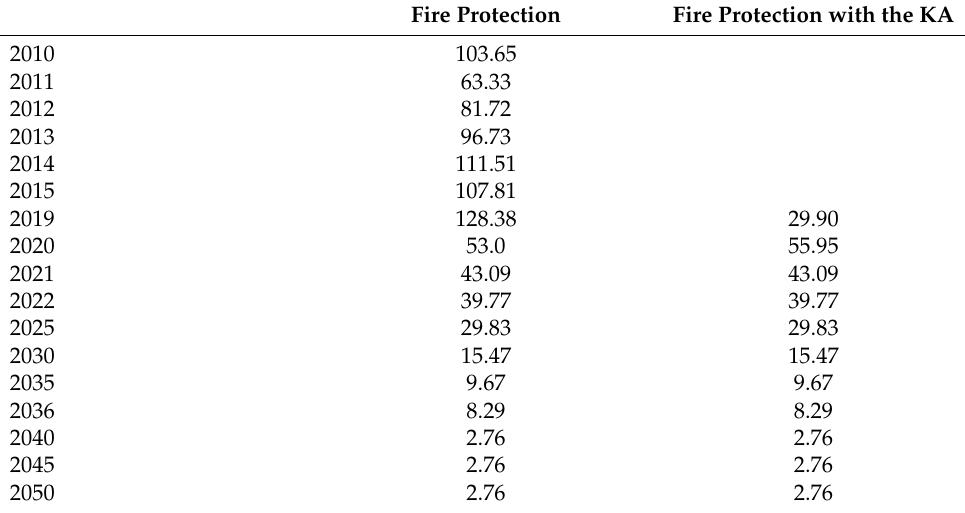
Table 7. F-gas consumption in fire protecting agents with and without the KA correction (kt CO 2 eq.). Fire Protection Fire Protection with the KA